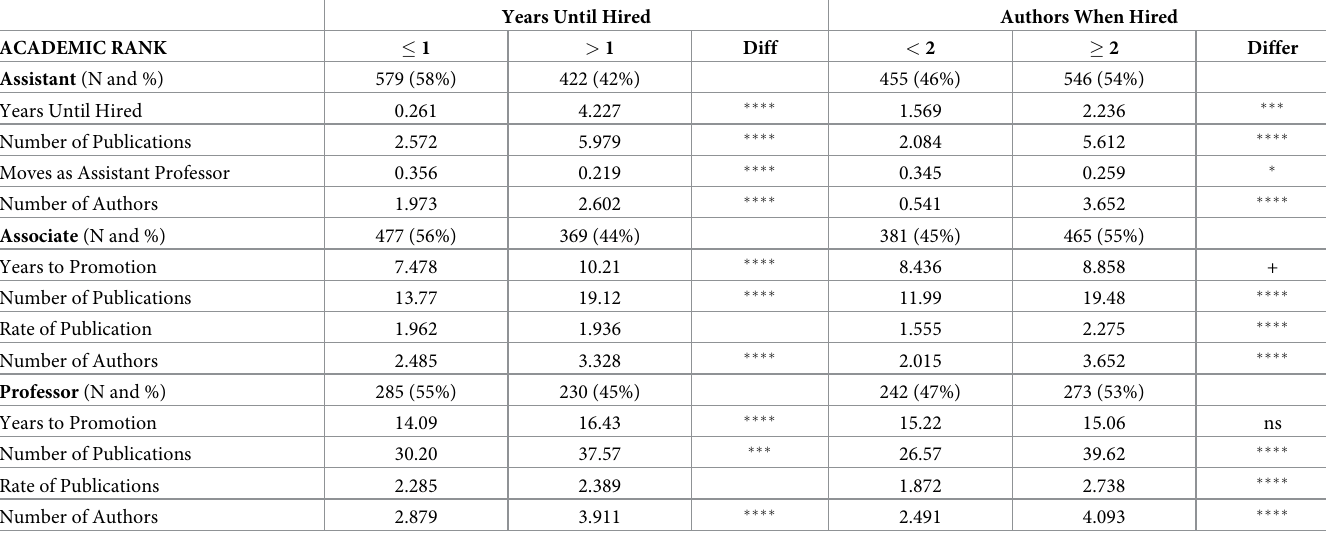
Table 6. Professors dichotomized by postgraduate experience and